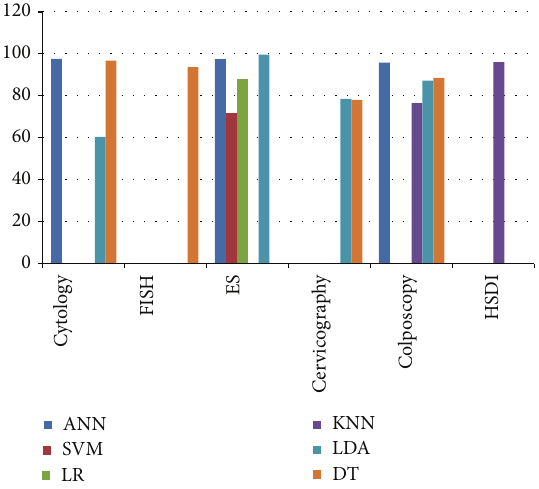
Figure 5: Performances of six classifiers generally for cervical precancerous